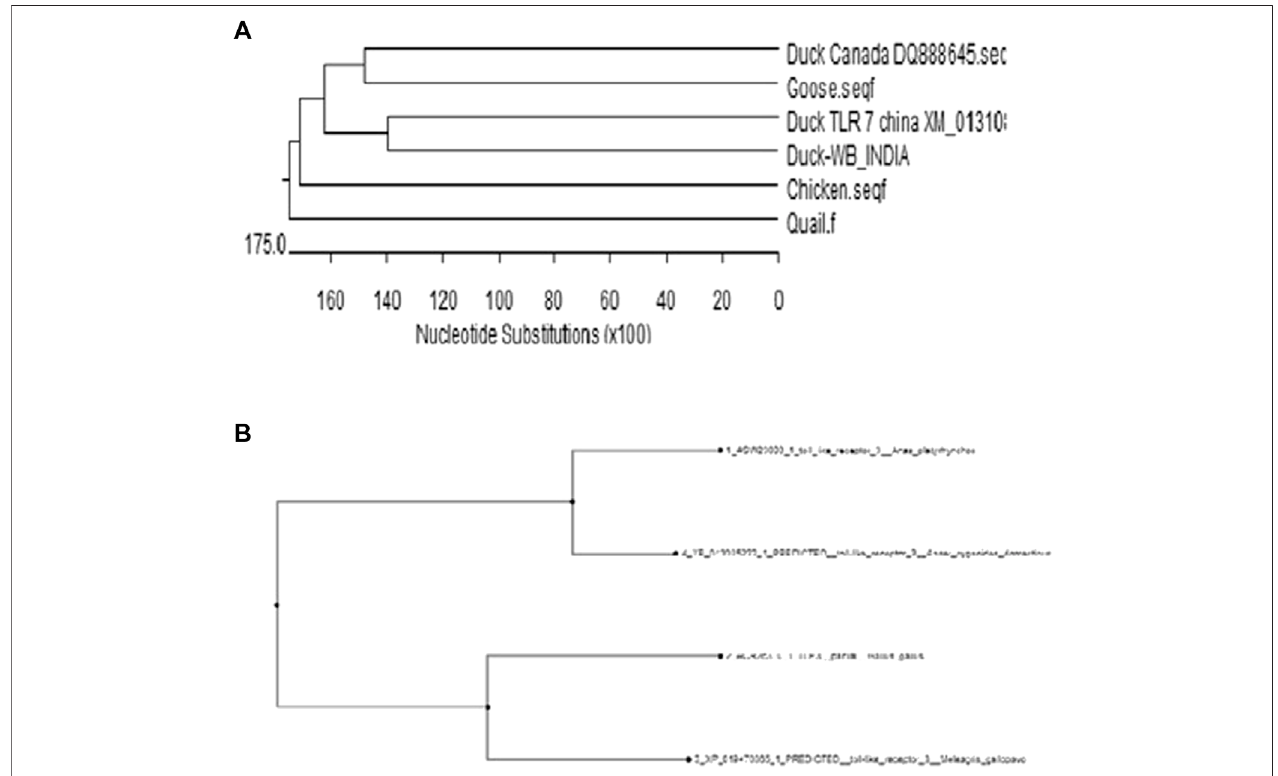
FIGURE 15 | (A) Molecular evolution of ducks reared globally in relation to other poultry species (Based on TLR7) (B) Molecular evolution of ducks reared globally (Based on TLR3).